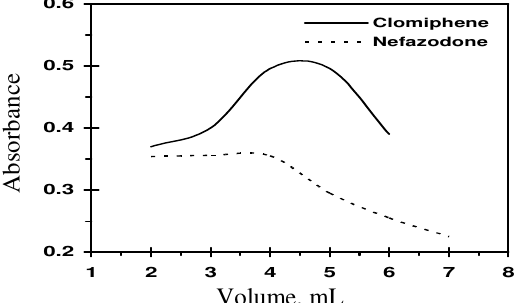
Figure 2. Effect of reagent volume on the absorbance of the complex formed with 1.2 and 1.4 mg/mL clomiphene citrate and nefazodone HCl, respectively.